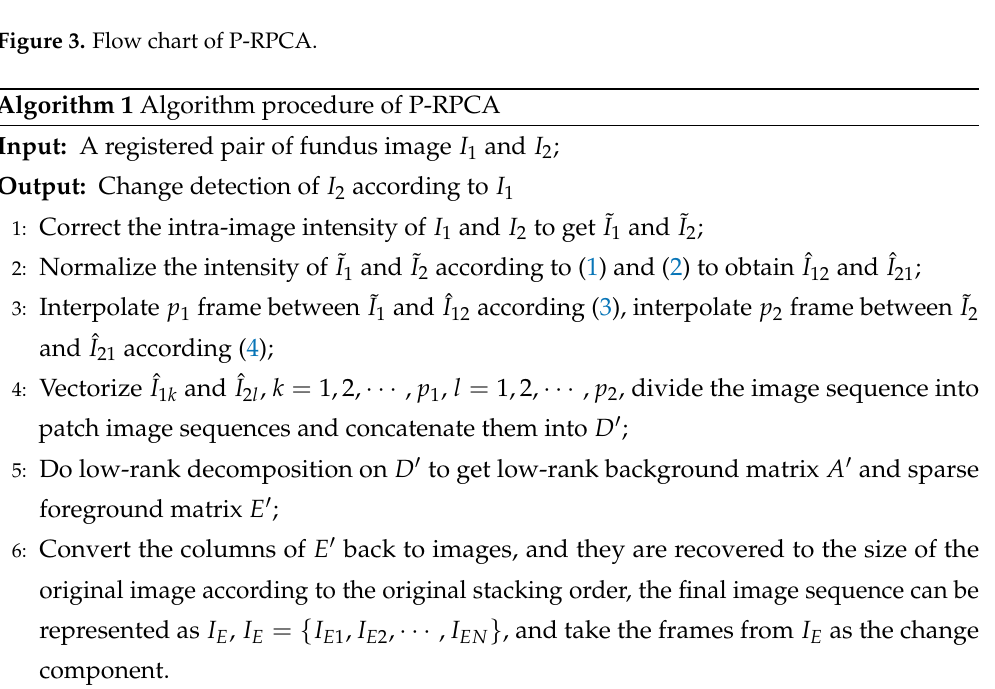
Figure 3. Flow chart of P-RPCA. Algorithm 1 Algorithm procedure of